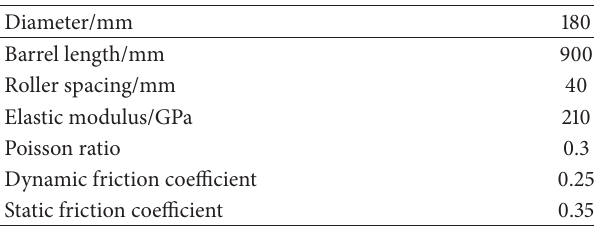
Table 2: Basic information about straightening roll.